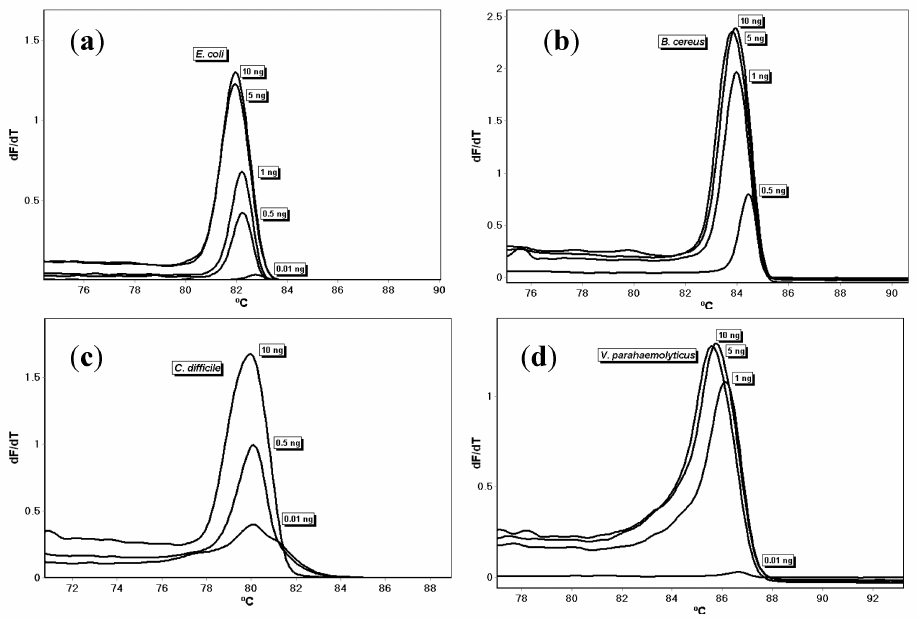
Figure 4. Melt curves of DNA dilution series for ( a ) E. coli , ( b ) B. cereus , ( c ) C. di ffi cile , and ( d ) V. parahaemolyticus